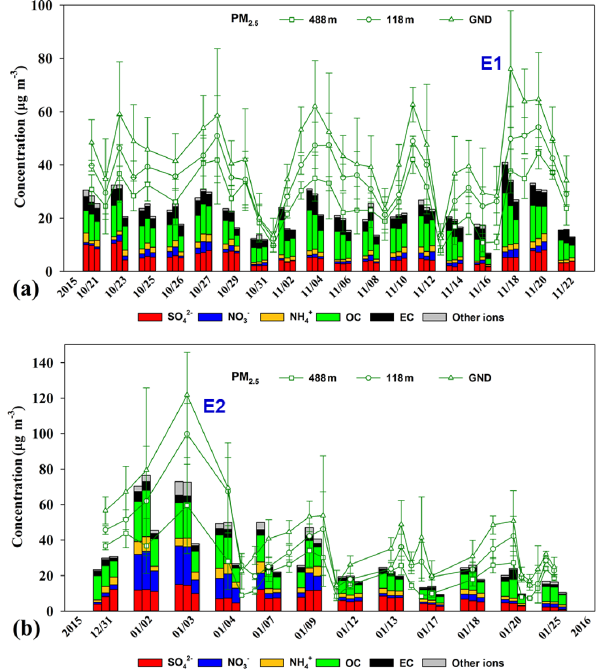
Figure 2. PM 2 . 5 mass and chemical component concentrations at ground level (GND), 118m, and 488m during the (a) autumnal and (b) winter sampling periods. The dates on the x axis are the sampling days. The stacked bar diagrams for each day represent chemical components at ground level (left), 118m (middle), and 488m (right). The green lines represent the daily averaged PM 2 . 5 mass concentration. E1 and E2 represent two haze episodes with daily average PM 2 . 5 concentrations on the ground site higher than 75gm − 3 . Error bars represent the standard deviations of the